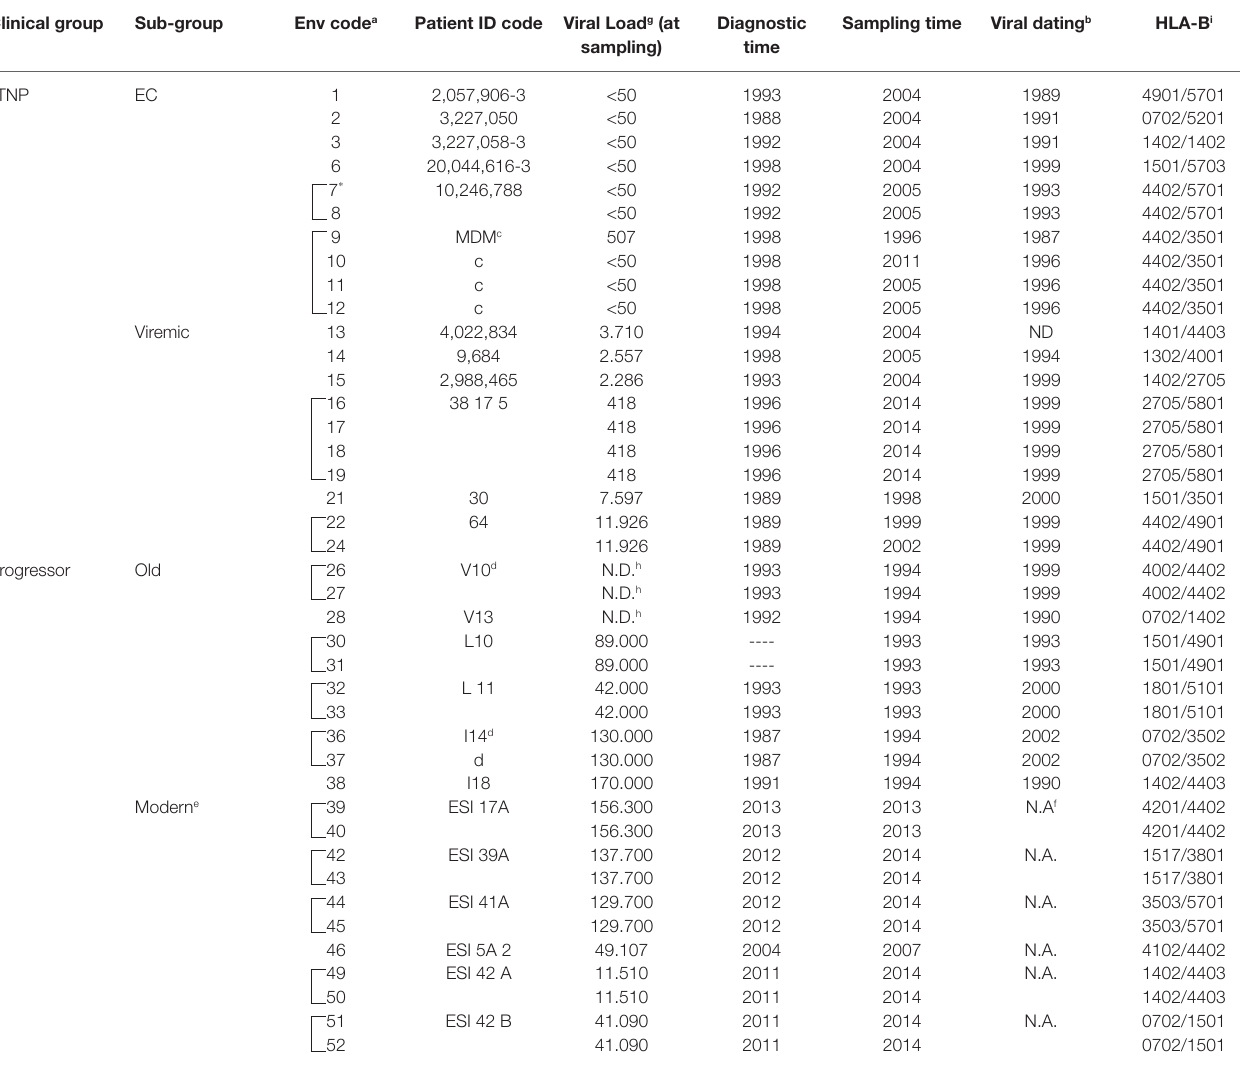
TABLE 1 | Epidemiological, clinical, and host characteristics of the viral Envs. Clinical